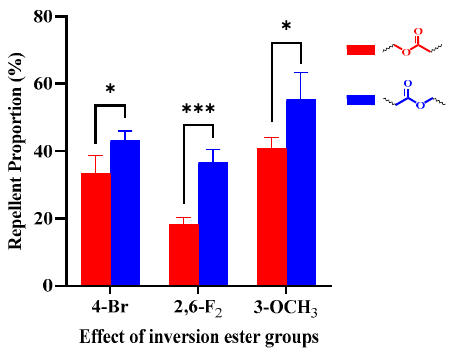
Figure 1. The effect of inversion ester groups on repellent activity against A. pisum ; Data represent the mean ± standard deviation. Significance calculated using T test (* p < 0.05, *** p < 0.001).